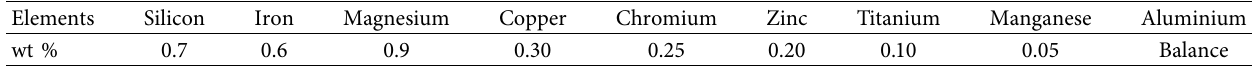
Table 1: Chemical arrangement of Al 6061.